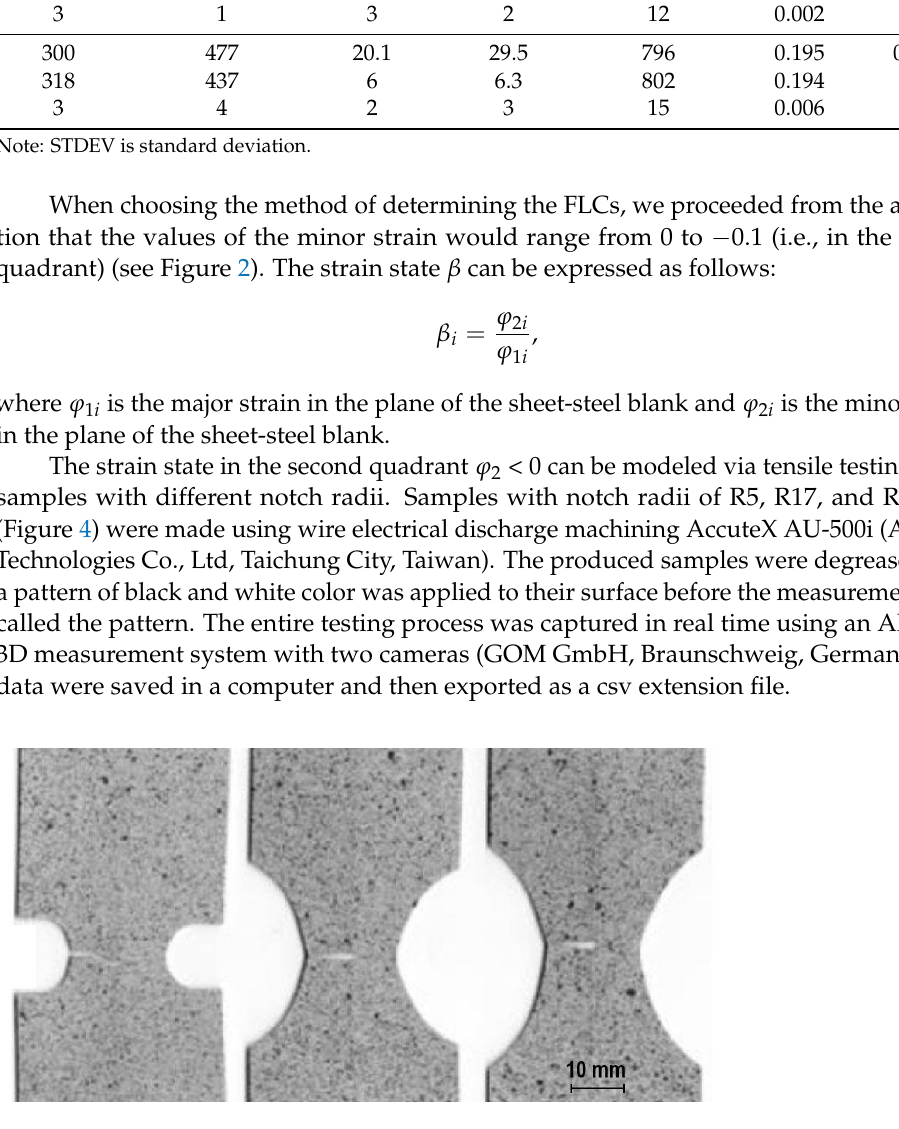
Table 4. The properties (at 90° to rolling direction) of base material and laser-welded material.